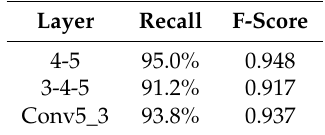
Table 4. Recall rate from different